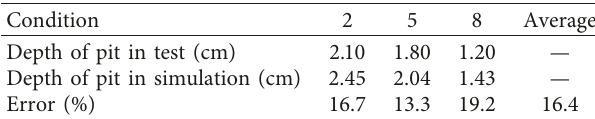
Table 8: The depth of pits and